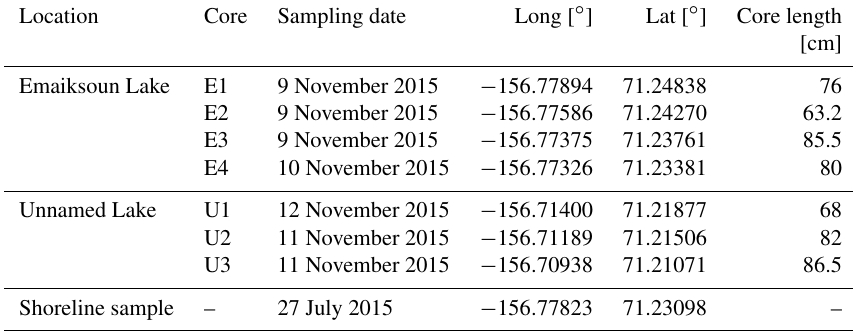
Table 1. Overview of sediment cores and shoreline sample